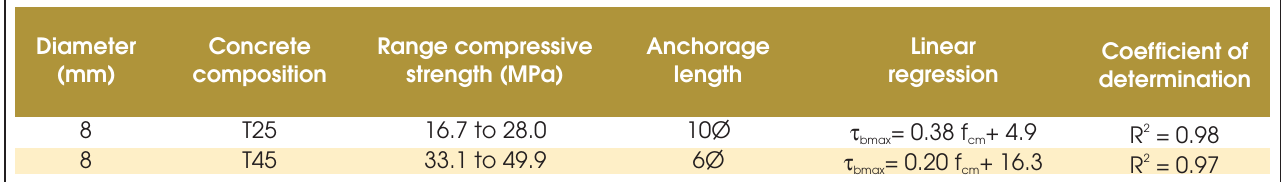
Table 3 – Equations of linear regression lines and their respective determination coefficients